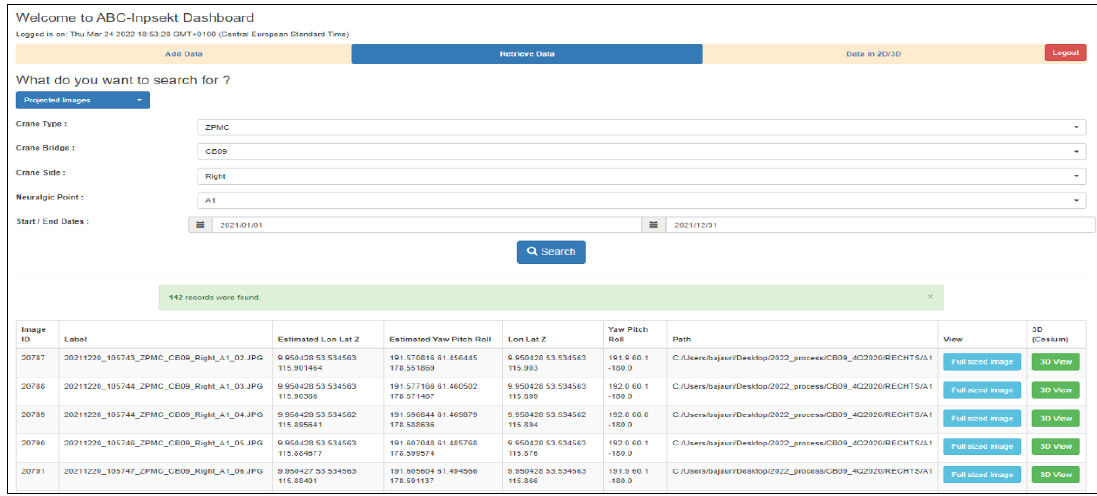
Figure 8 . The internet browser-based GUI to add, query and view data (e.g. UAV imageries and crane defects detected using Machine Learning